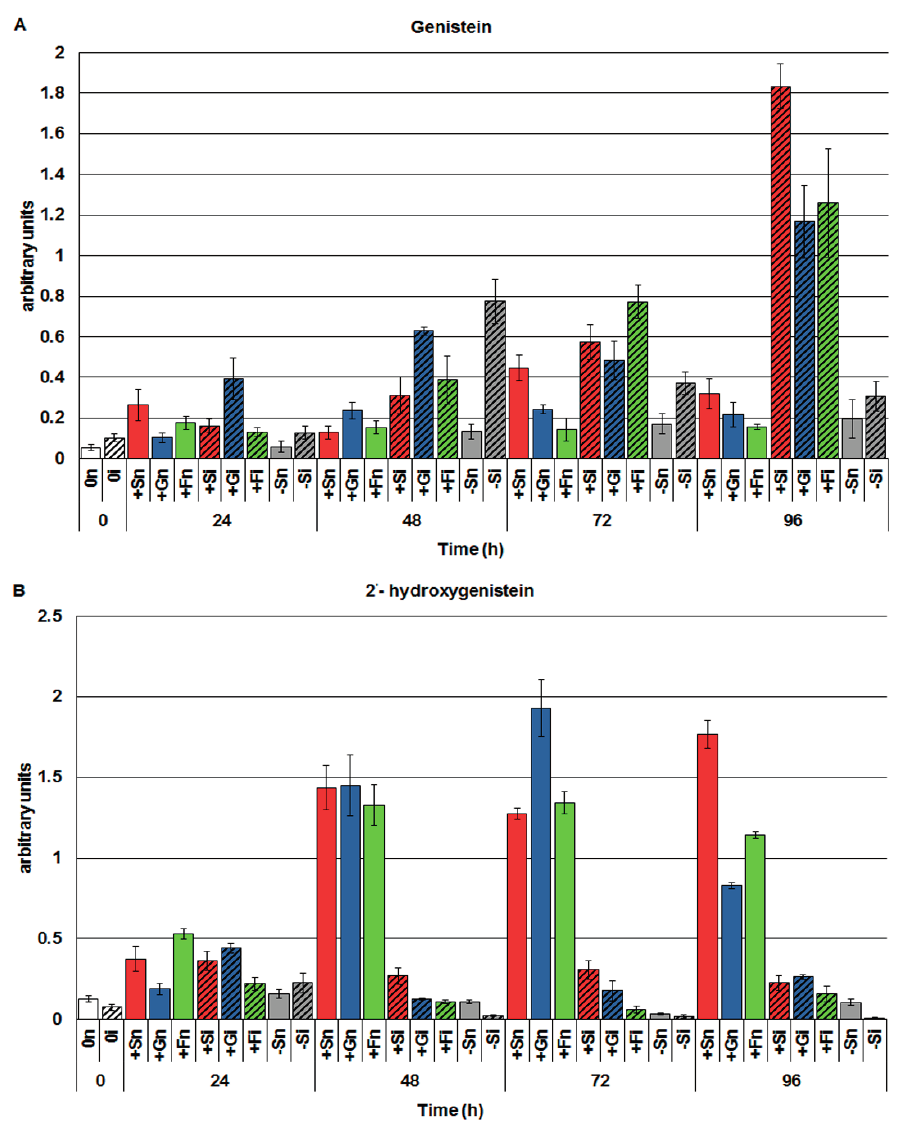
Figure 1. The effect of sucrose, glucose and fructose on accumulation of genistein ( A ) and other isoflavones, i.e. , 2'-hydroxygenistein ( B ), wighteone ( C ) and luteone ( D ), in in vitro cultured embryo axes of Lupinus luteus L. cv. Juno infected with Fusarium oxysporum f.sp. lupine . Statistical significance of differences between the average values of each pairs for accumulation of genistein and other isoflavones. Statistically significant differences ( p -value) was assumed at p <